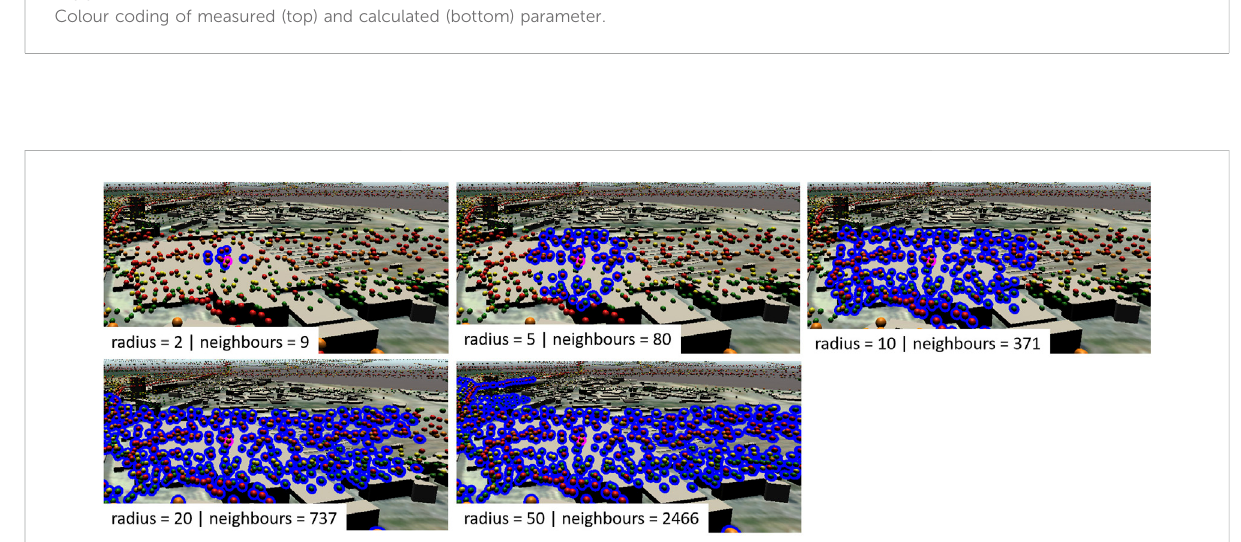
FIGURE 3 Calculated neighbours (blue outline) for an example GPS point (magenta outline) for different radius in space time cube visualization